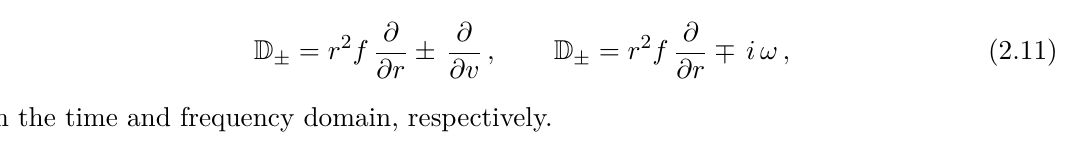
, ∂ , ∂ } , while { dr , dv − dr , dx i } provides the dual + v i r 2 f r 2 f